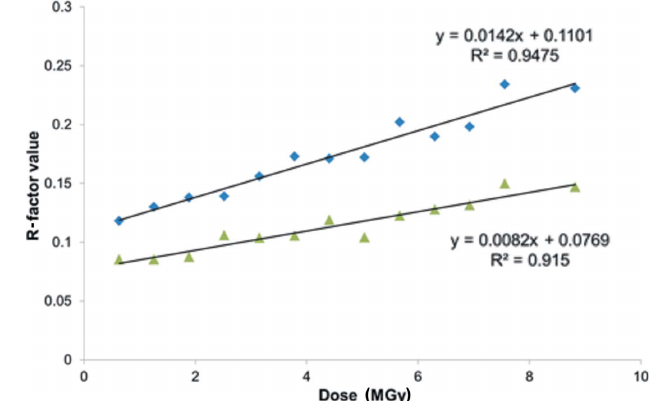
Figure 3 The change in R merge (diamonds) and traditional refinement atomic R - factor (triangles) values as a function of absorbed dose, where ¼ ð P j I (cid:2) h I i jÞ = ð P h I iÞ and R factor ¼ ð P jj F R merge jÞ = ð P j F obs